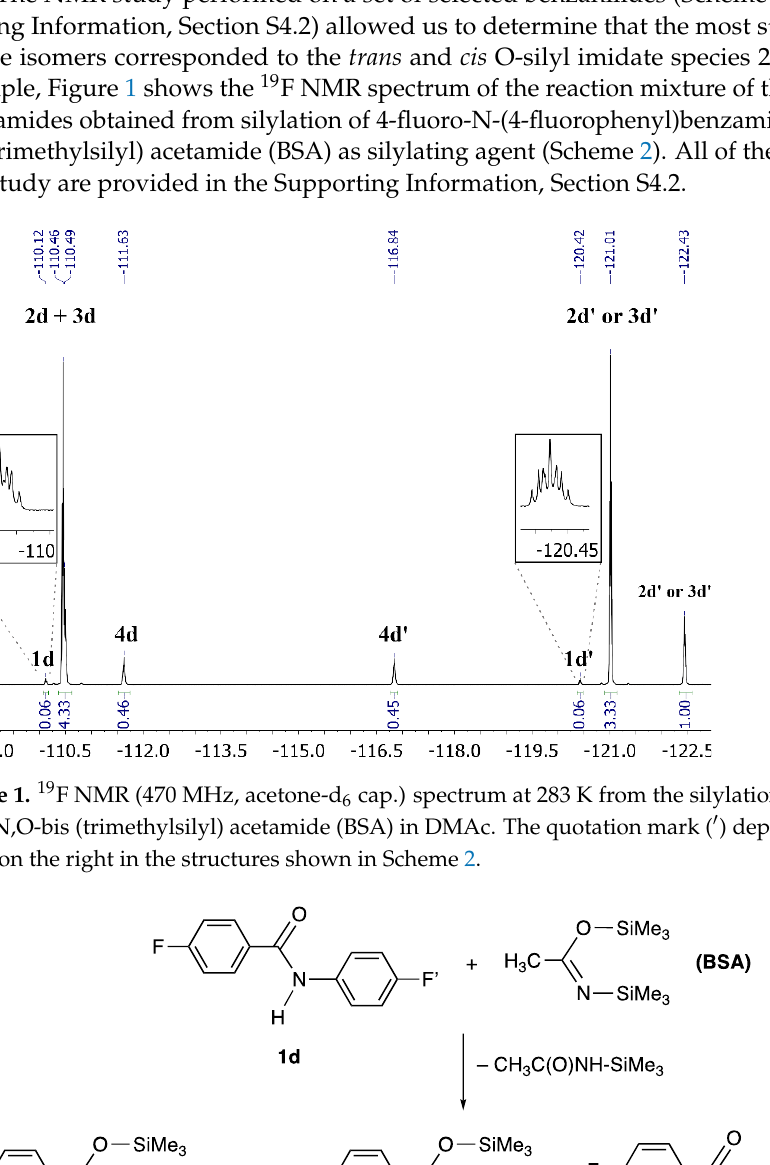
Figure 1. 19 F NMR (470 MHz, acetone-d 6 cap.) spectrum at 283 K from the silylation reaction of 1d with N,O-bis (trimethylsilyl) acetamide (BSA) in DMAc. The quotation mark ( ′ ) depicts the fluorine atom on the right in the structures shown in Scheme 2. The isomer stability scale determined by DFT (B3LYP/6-31G(d,p)) molecular model- ing turned out to be completely the same as that determined in the NMR study for the silylated benzanilide of Scheme S3 (Supporting Information, Section S5.2). It should be noted that this cis O-silyl imidate isomer has a completely different con- formation from that of the N-silyl amide (silylated benzanilide 4, Scheme S3) and the trans O-silyl imidate isomer (silylated benzanilide 2, Scheme S3). With the structures optimized by DFT calculations, macromolecular structures of PPTA were created using the MaterialsStudio package [40].